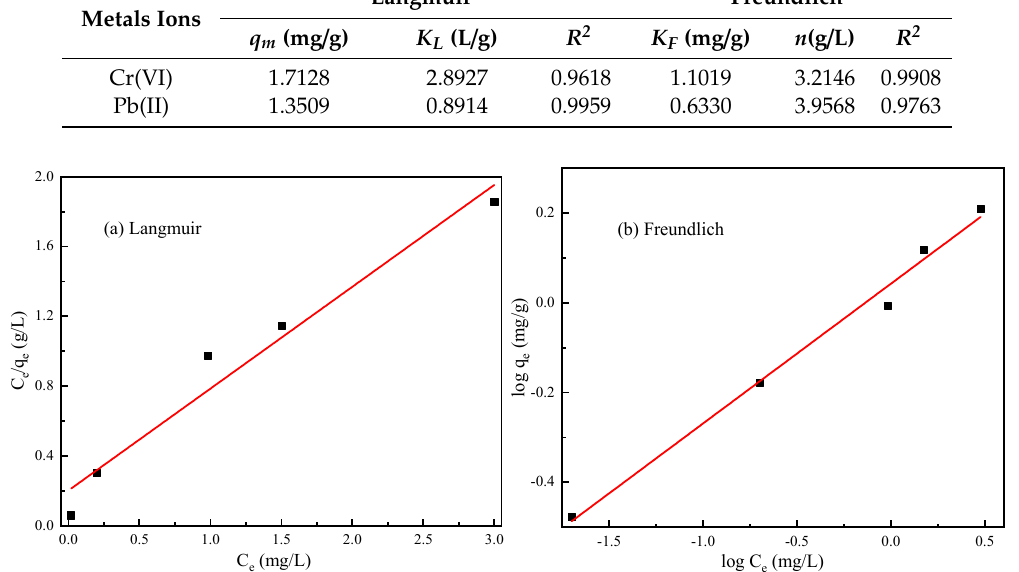
Table 5. Isotherm parameters for Cr(VI) and Pb(II) adsorption by Fe-REC. Metals Ions